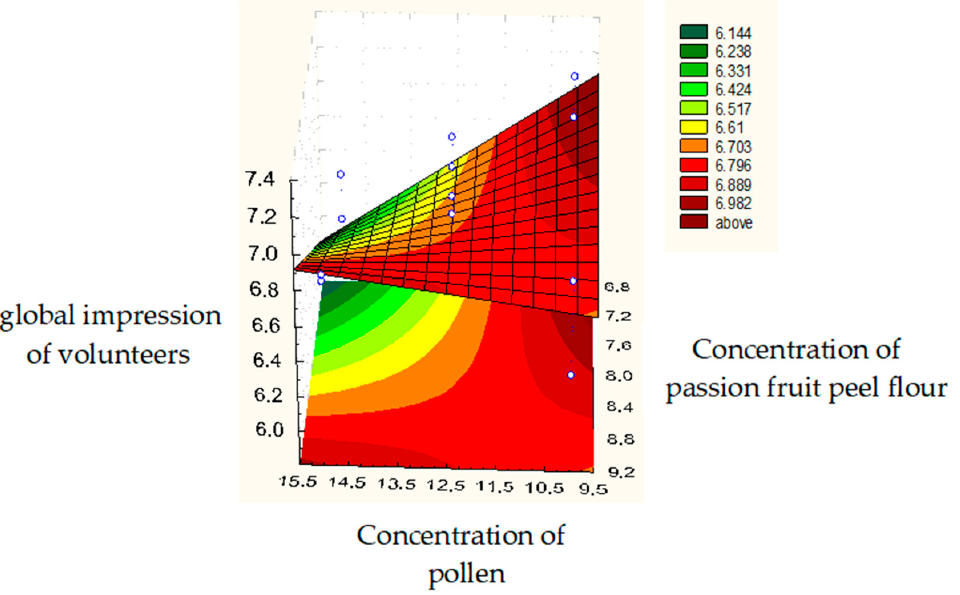
Figure 3. Surface-response chart of volunteers’ global impression of the cereal bar regarding the concentrations of passion fruit peel flour and pollen.